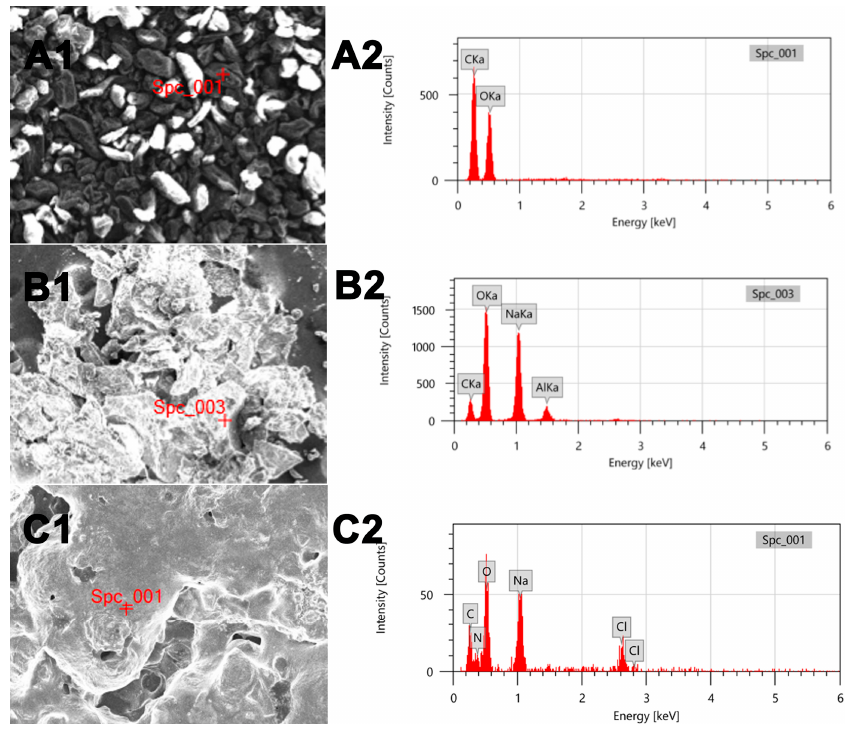
Figure 3. SEM images and EDX spectra of ( A1,A2 ) SG, ( B1,B2 ) eSG, and ( C1,C2 ) cSG.